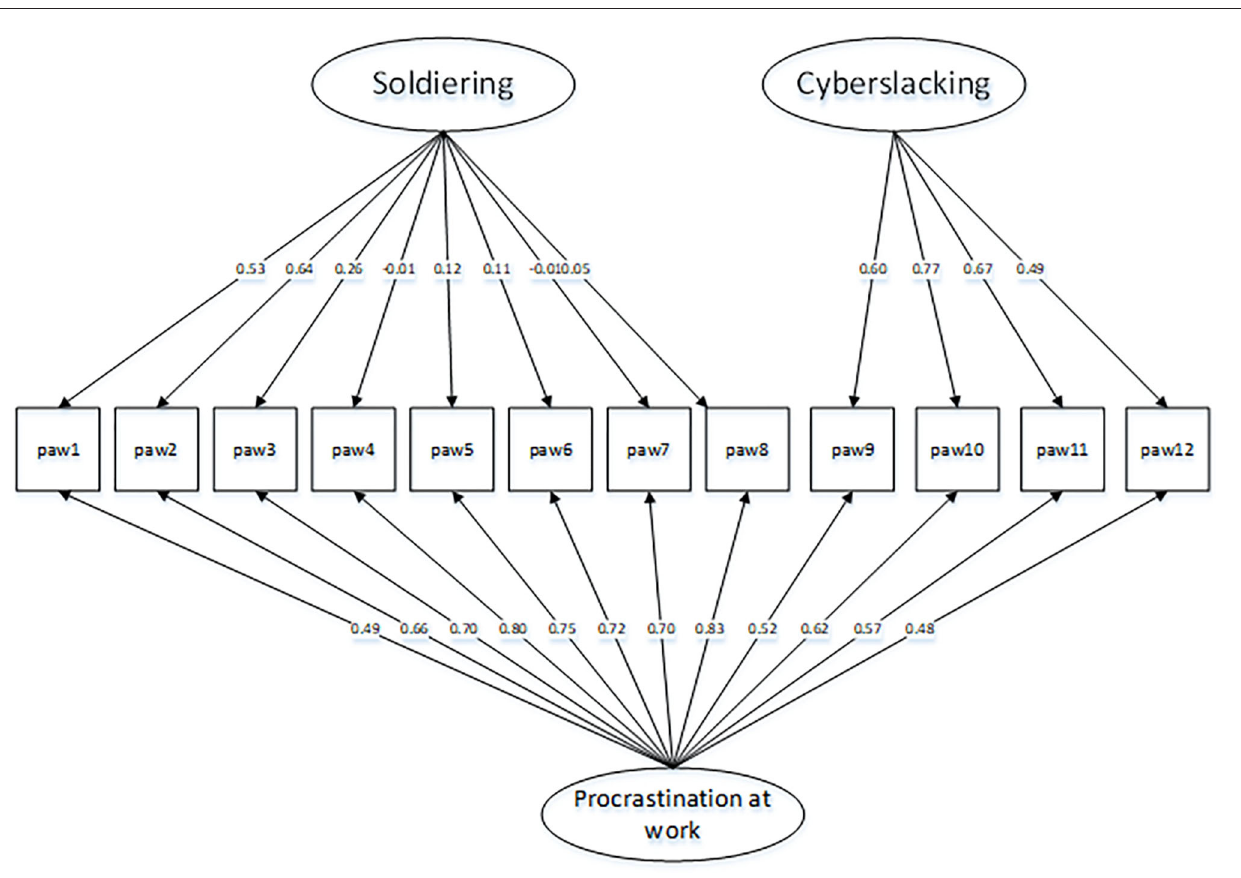
FIGURE 1 | Final confirmatory bifactor model of procrastination at work scale in Sample B. Fit is [ χ 2 (42) Tucker-Lewis